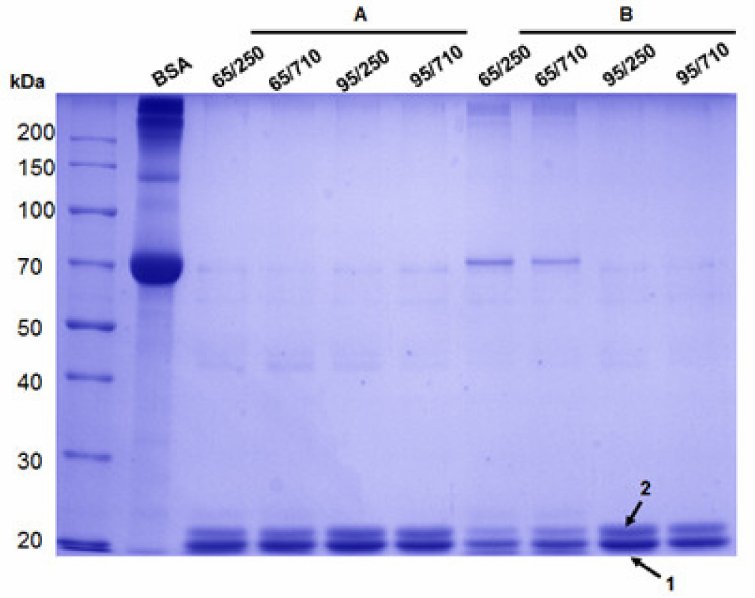
Figure 1. SDS-PAGE electrophoresis of extracted zein from maize inbred KWS 3381 after 15 min using ultrasonic bath ( A ) and ultrasonic homogenizer ( B ), where BSA: bovine serum albumin standard solution; 65/250: zein extracted with 65% ethanol solution from 250 µ m flour granulation; 65/710: zein extracted with 65% ethanol solution from 710 µ m flour granulation; 95/250: zein extracted with 95% ethanol solution from 250 µ m flour granulation; and 95/710: zein extracted with 95% ethanol solution from 710 µ m flour granulation.